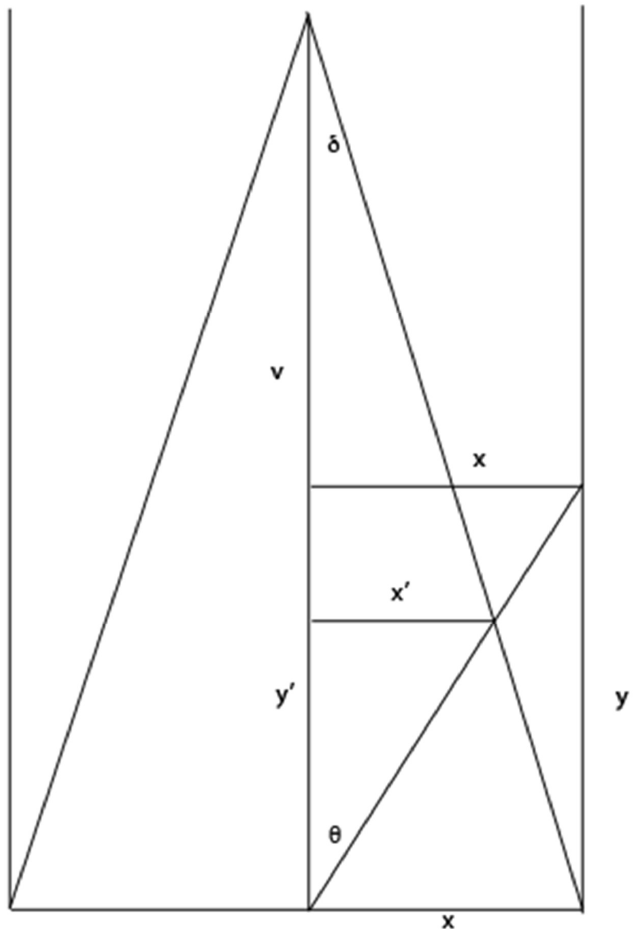
Figure A1. Diagram illustrating parallel alleys transformed according to Hatfield’s Perspective-Based model.